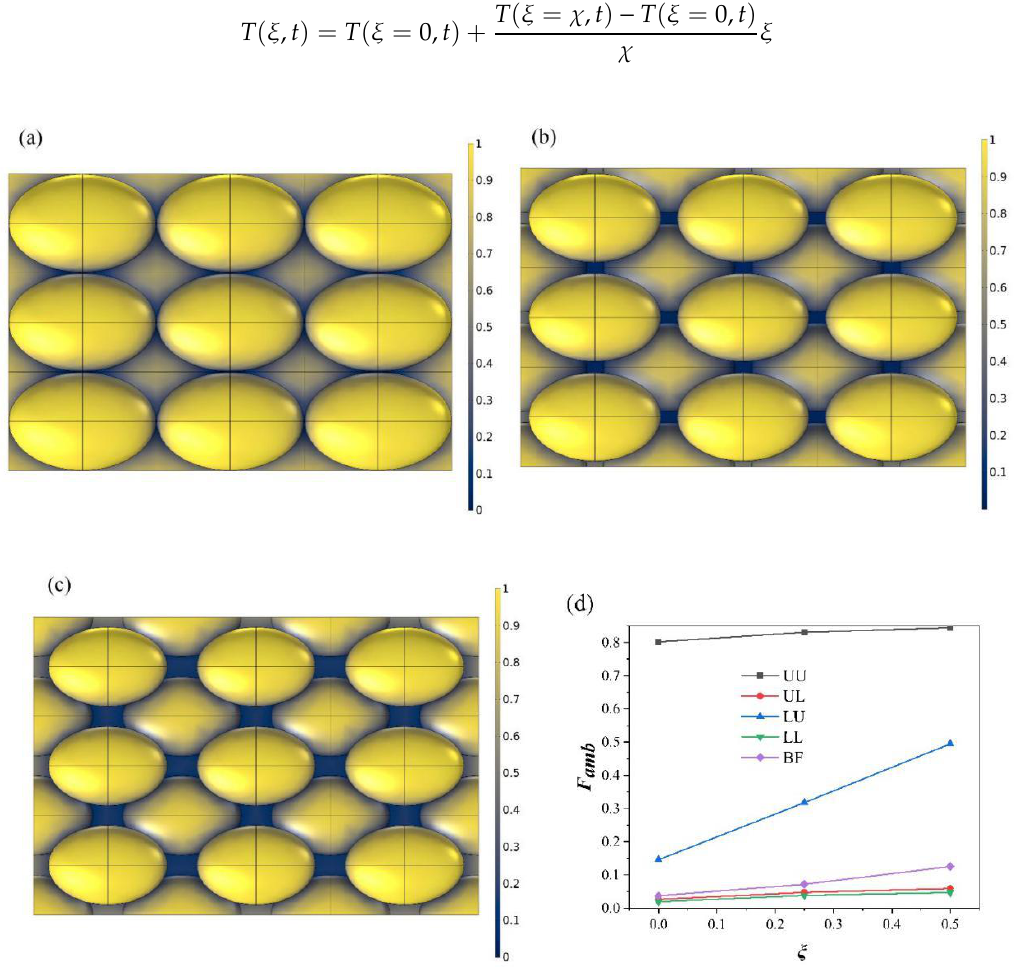
Figure 13. Effect of offset ξ on the variation of ambient view factor F amb . ( a ) ξ = 0 ( b ) ξ = 0.25 ( c ) ξ = 0.5 ( d ) The influence curve of ξ on F amb .